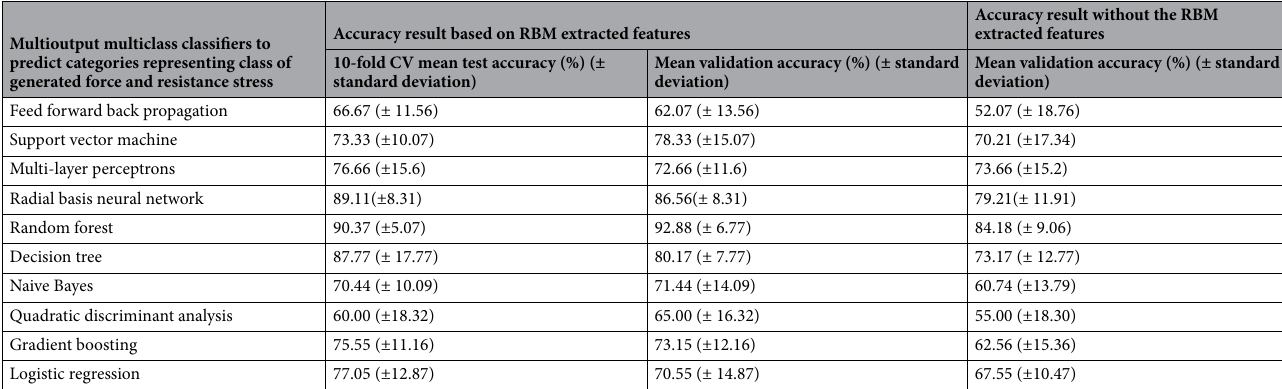
Table 1. Multioutput multiclass classification results from the ten different machine learning classifiers. A random forest (RF) classifier was the best performing classifier in the multiclass classification problem while predicting the generated force and the stress by a movement of a SMA body. It was found that a restricted Boltzmann machine (RBM) was able to extract features efficiently to enhance the prediction accuracies of the classifiers. These findings led to a predictive system which can help to control and actuate the SMA structures more